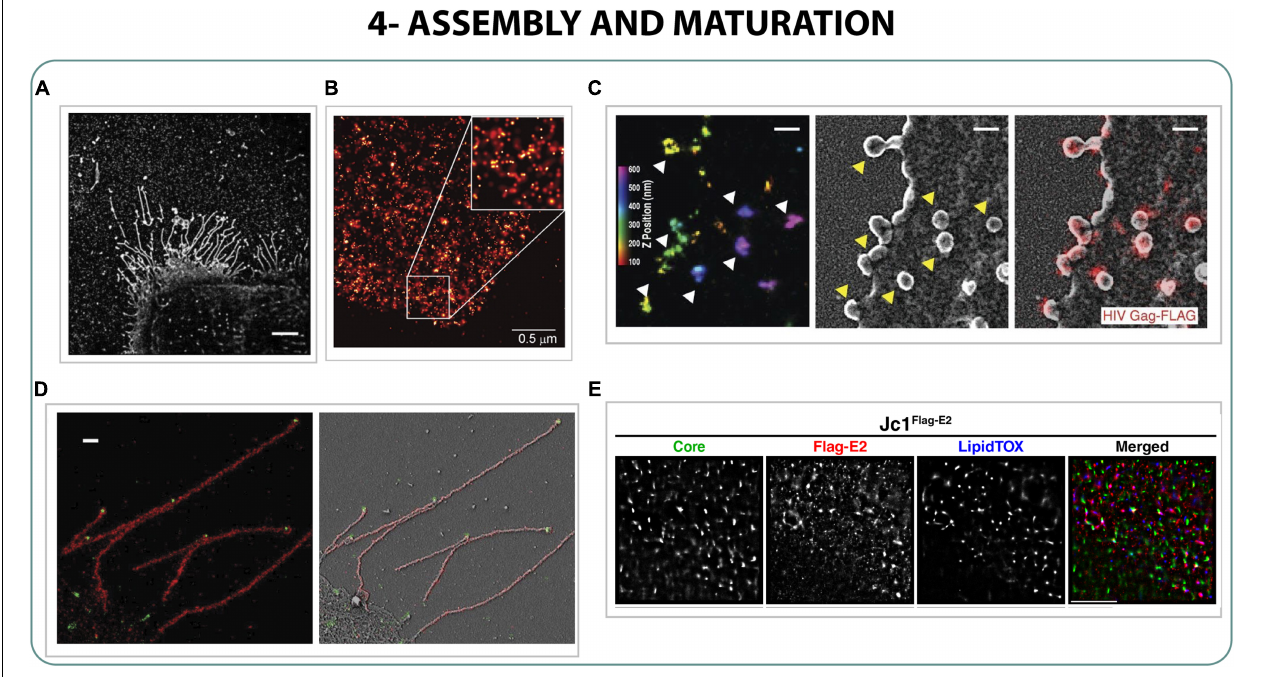
FIGURE 5 | Assembly and maturation. (A) STORM images of Udorn influenza filaments on infected cells. Scale bar 5 µ m (Kolpe et al., 2019). (B) PALM image of COS-7 expressing Gag HIV-1 protein (Betzig et al., 2006). (C) Correlative iPALM-SEM of Gag protein on cells infected with HIV-1. Scale bar 250 nm (Engelenburg et al., 2014). (D) Correlative 3D STORM and SEM of the proteins M1 (red) and vRNP (green) of influenza filaments of Udorn strain on infected cells. Scale bar 500 nm (Kim et al., 2015). (E) 3-color STORM of core, flag-E2 and lipid droplets of Hepatitis C (Eggert et al.,